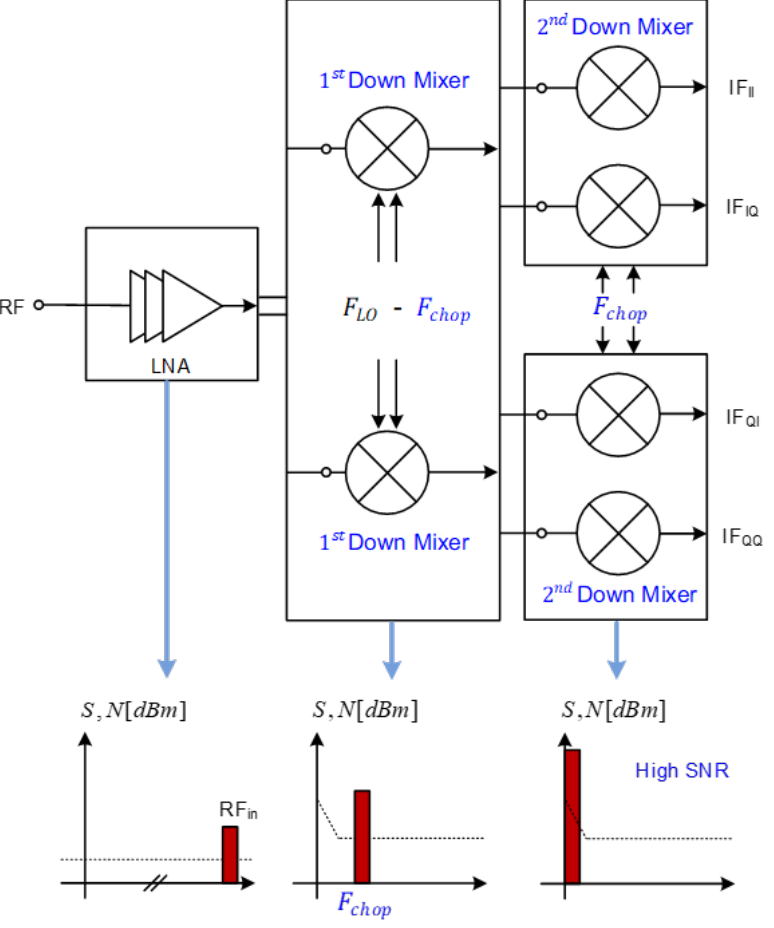
Figure 12. Double conversion receiver